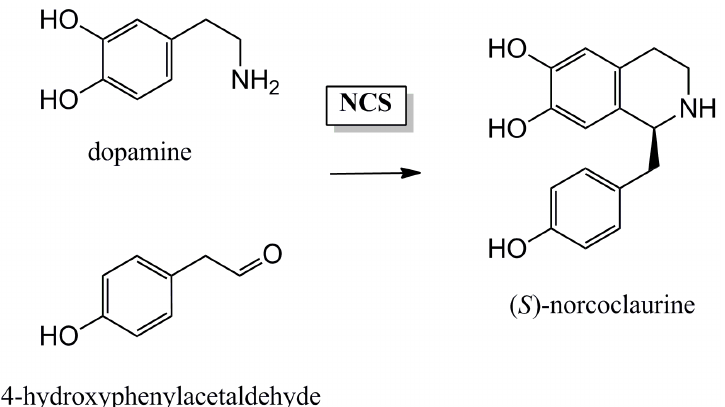
Figure 4. Formation of ( S )-norcoclaurine in the biosynthesis of benzylisoquinoline alkaloids by a Pictet-Spengler reaction. The condensation reaction between the two tyrosine derived precursors dopamine and 4-hydroxyphenylacetaldehyde is catalysed by norcoclaurine synthase